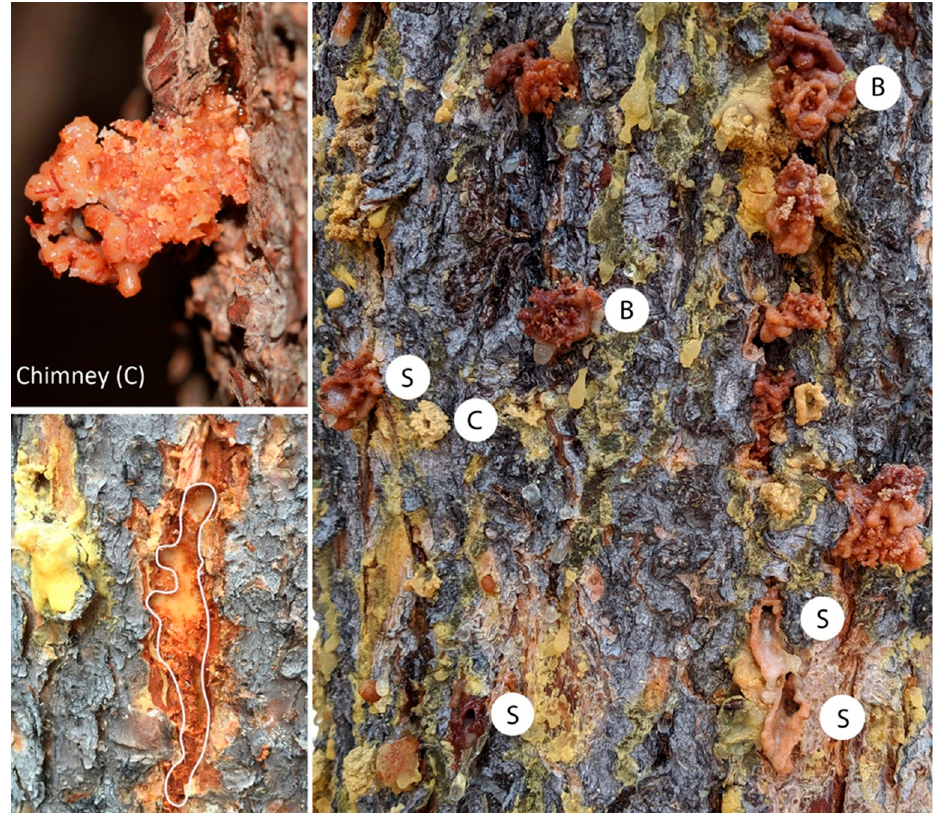
Figure 6. Distinguishing characteristics of Dendroctonus attacks to P. contorta in the southern Rocky Mountain subalpine forest include the shape of their pitch tubes and the length of their galleries. Clockwise from top left: ( 1 ) the chimney ‐ like pitch tube of D. ponderosae is perpendicular to the tree with a near round outer border, ( 2 ) a mix of different pitch tube shapes with bulky ( B ) and slide ‐ forming ones ( S ) by D. rufipennis and a chimney ‐ shaped one ( C ) made by D. ponderosae , and ( 3 ) the turning notches in the short D. rufipennis egg gallery. Photos by J. Mercado. Table 1. Quantified characters of Dendroctonus spp. bark beetles attacking subalpine P. contorta in the SRM during this study. Note: D. murrayanae Hopk. adults or their attacks were not found during this study. Attack Height Pitch Tube Type Egg Gallery Length